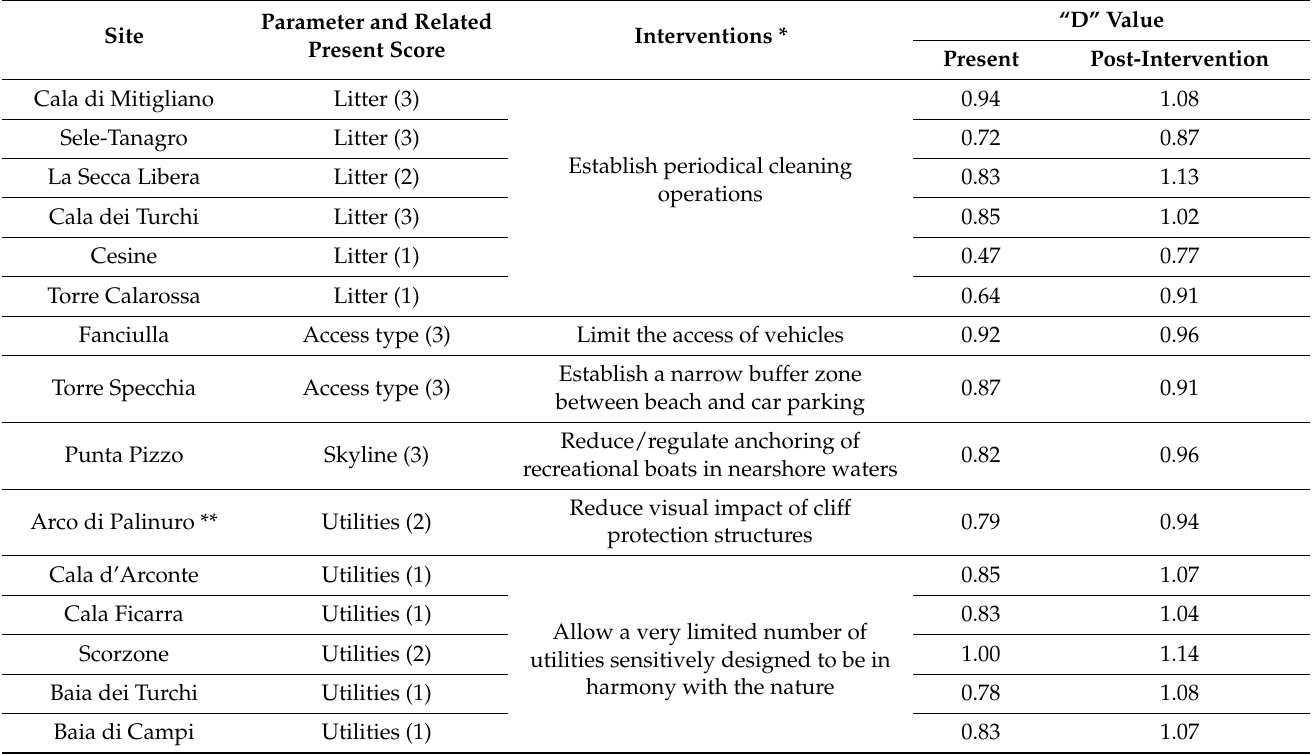
Table 2. Proposal of judicious interventions to increase sites attractiveness and upgrade of associated evaluation index